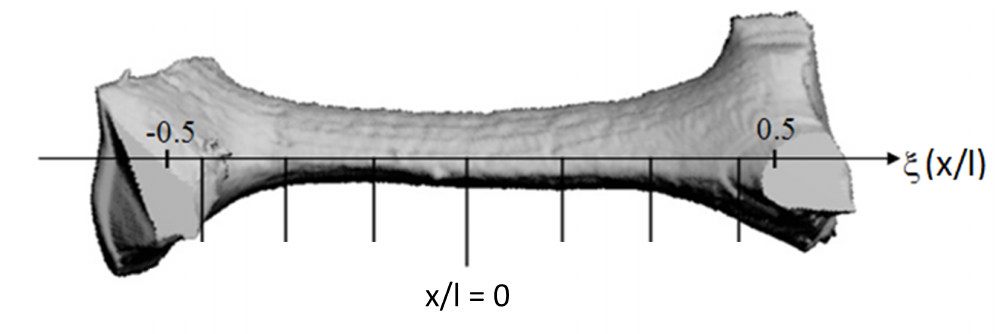
Figure 4. An illustration of the axial thickness variation along the strut length for a foam made by Energy Research and Generation (ERG)